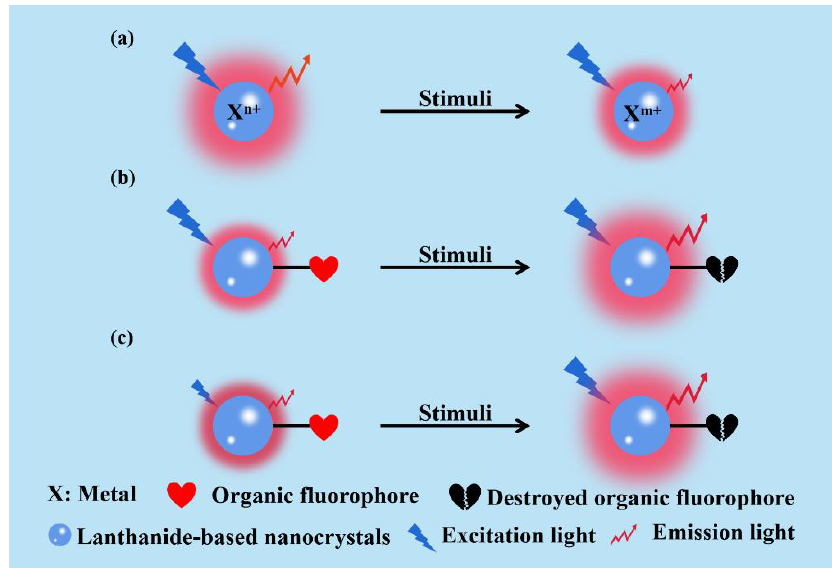
Figure 6. ( a ) Schematic illustration of an inorganic ion of LnNCs sensing. ( b ) Schematic of organic dyes on the surface of LnNCs for sensing by affecting the luminescence of LnNCs themselves. ( c ) Schematic of sensing that the surface organic dyes of LnNCs indirectly affect the luminescence by influencing the excitation light source.